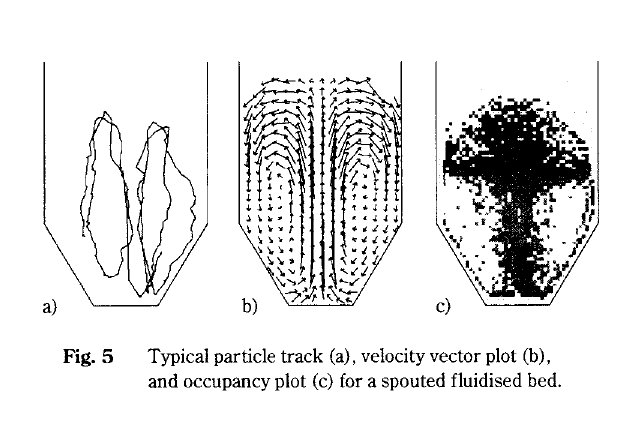
Typical particle track (a). velocity vector plot (b), and occupancy plot (c) for a spouted fluidised